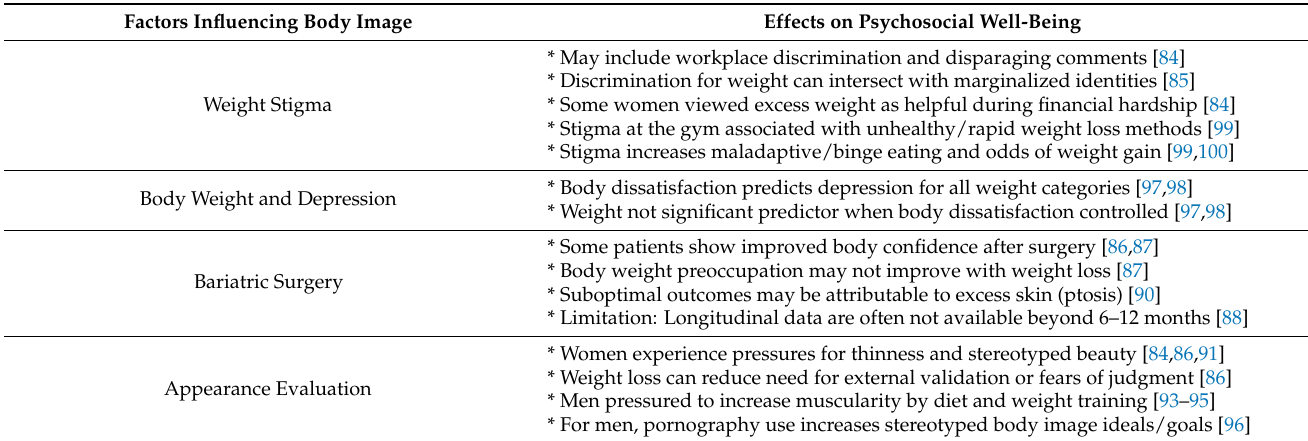
Table 4. Factors related to body image appraisal and their psychosocial